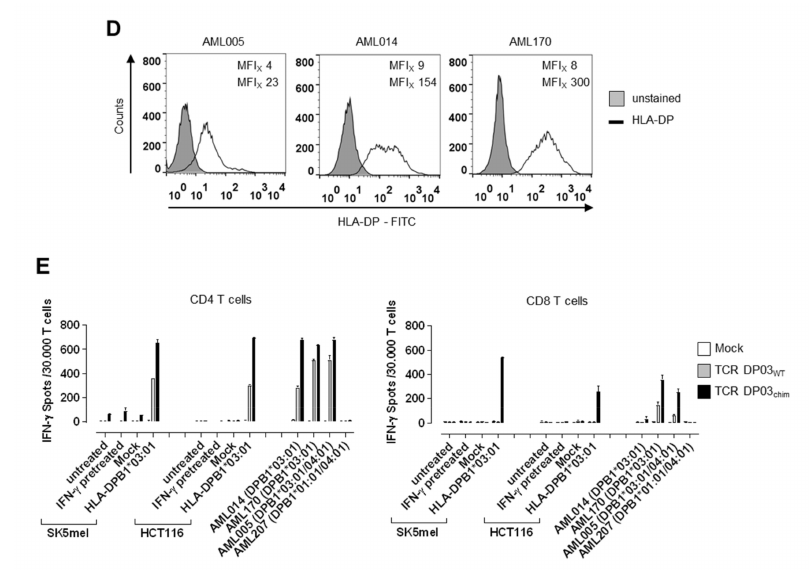
Figure 5. Impact of HLA-DP cell surface expression level on T cell recognition. ( A ) Cos-7, SK29mel, Saos, and SW480 tumor cell lines were transfected with HLA-DPA1*01:03 and -DPB1*03:01 IVT-RNA and used as target cells in IFN- γ ELISpot assay. Pre-stimulated CD4 (left panel) and CD8 (right panel) T cells from an HLA-DPB1*03:01 negative donor were transfected with TCR DP03 WT , TCR DP03 chim or Mock and incubated with target cells in an E: T ratio of 0.3:1. ( B ) IFN- γ spot formation by indicated T cell populations upon incubation with HLA-DPB1*03:01 positive primary fibroblasts (Fb) from donor 17 that were either pretreated with IFN- γ or electroporated with HLA-DPA1*01:03 and -DPB1*03:01 coding RNA. EBV-LCL from HLA-DPB1*03:01 positive and negative donors served as controls. ( C ) HLA-DP surface expression on HLA-DPB1*03:01 positive cells (primary fibroblasts, SK5mel, and HCT116) was determined by flow cytometry. Cells were left untreated (filled grey line), pretreated with IFN- γ for four days (solid black line) or electroporated with RNA encoding HLA-DPA1*01:03 and -DPB1*03:01 (black dotted line). MFI values of HLA-DP staining are shown in the following order: untreated (upper value), IFN- γ pretreated (middle value), HLA-DP electroporated (lower value). ( D ) Primary AML samples from individual HLA-DPB1*03:01 positive patients were analyzed cytofluorometrically for HLA-DP expression. MFI values of HLA-DP staining were shown for unstained (upper value) or HLA-DP stained (lower value) cells. ( E ) IFN- γ spots formed upon stimulation of indicated CD4 and CD8 T cell populations by tumor cell lines SK5mel and HCT116 that were either left untreated, IFN- γ pretreated or electroporated with HLA-DPA1*01:03 and -DPB1*03:01 encoding RNA at an E:T ratio of 0.6:1. In addition, untreated primary AML blasts from individual HLA-DPB1*03:01 positive and negative patients were also used as target cells. Standard deviations of means of IFN- γ spot formation are shown for two technical replicates and experiments were performed with two ( A ) or three ( B , E ) di ff erent T cell donors, from which one representative is